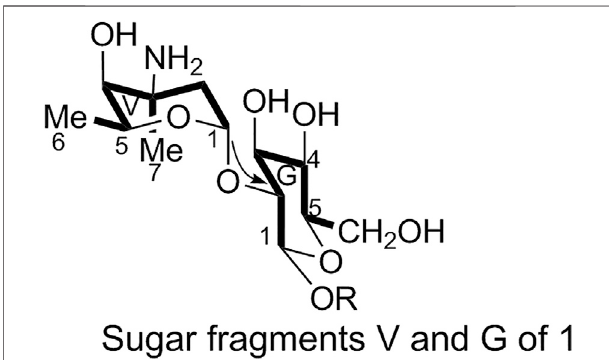
FIGURE 2 | Sugar fragments V and G of